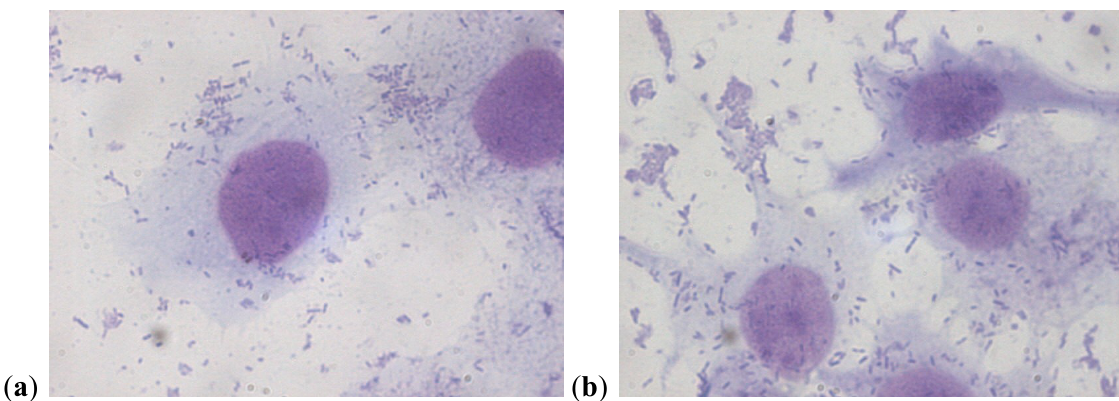
Figure 3. ( a )( b ) P. mirabilis adherent to a cell on a control